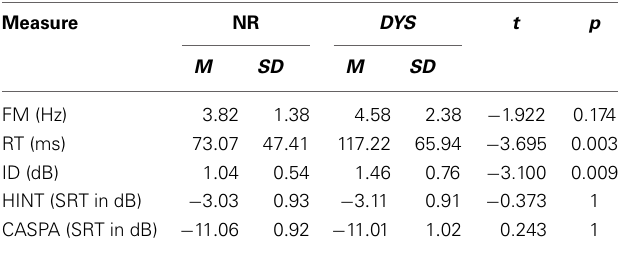
Table 3 | Auditory and speech-in-noise measures: descriptive statistics and t and p -values from independent t -tests.